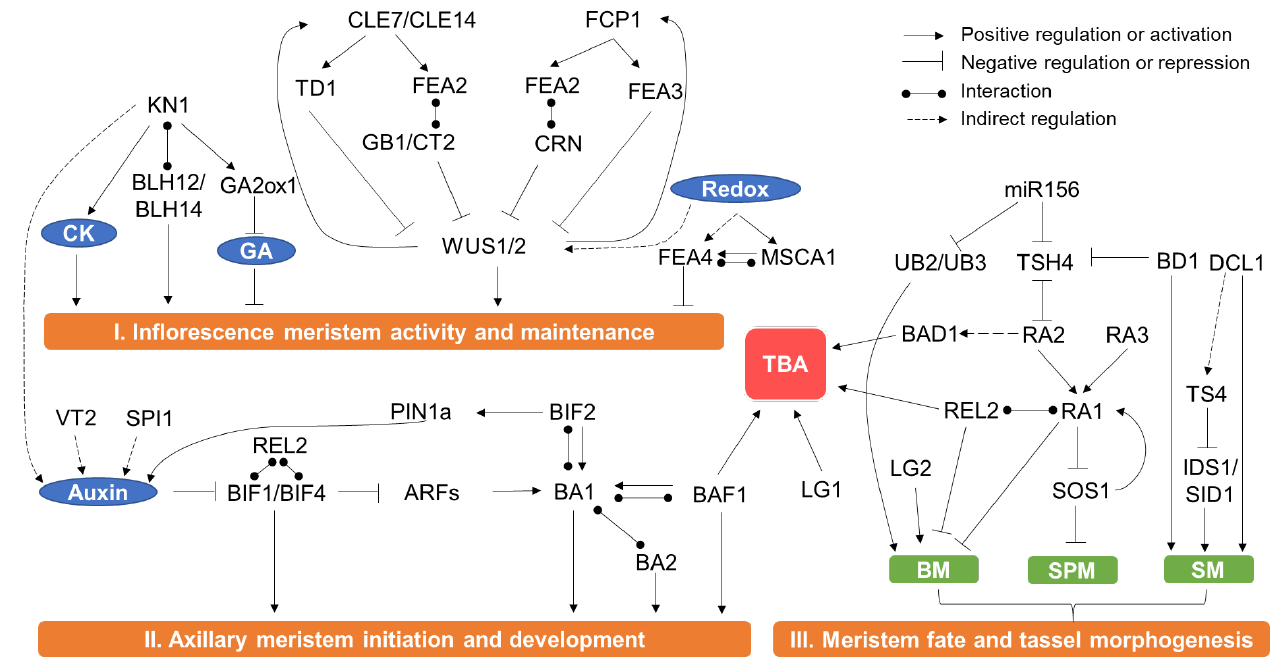
Figure 3. Key regulators and molecular pathways controlling male inflorescence development in maize. ( I ) Models for the roles of the CLV-WUS feedback pathway, KNOX-type proteins and FEA4 activities controlling inflorescence meristem activity and maintenance in maize. ( II ) Models of auxin biosynthesis, and signaling pathway in maize AM initiation and development. ( III ) Models of RAMOSA pathway and miRNA mediated gene regulation for inflorescence meristem fate and tassel morphogenesis. BM, branch meristem; CK, cytokinin; GA, gibberellin; SM, spikelet meristem; SPM, spikelet-pair meristem; TBA, tassel branch angle. Table 1. Known genes regulating male inflorescence development in maize.